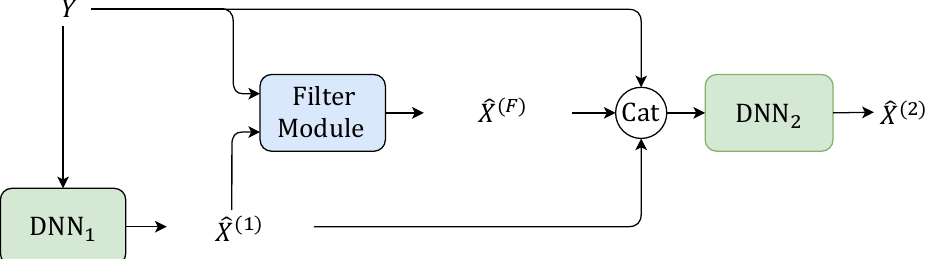
Figure 1. The framework of the proposed